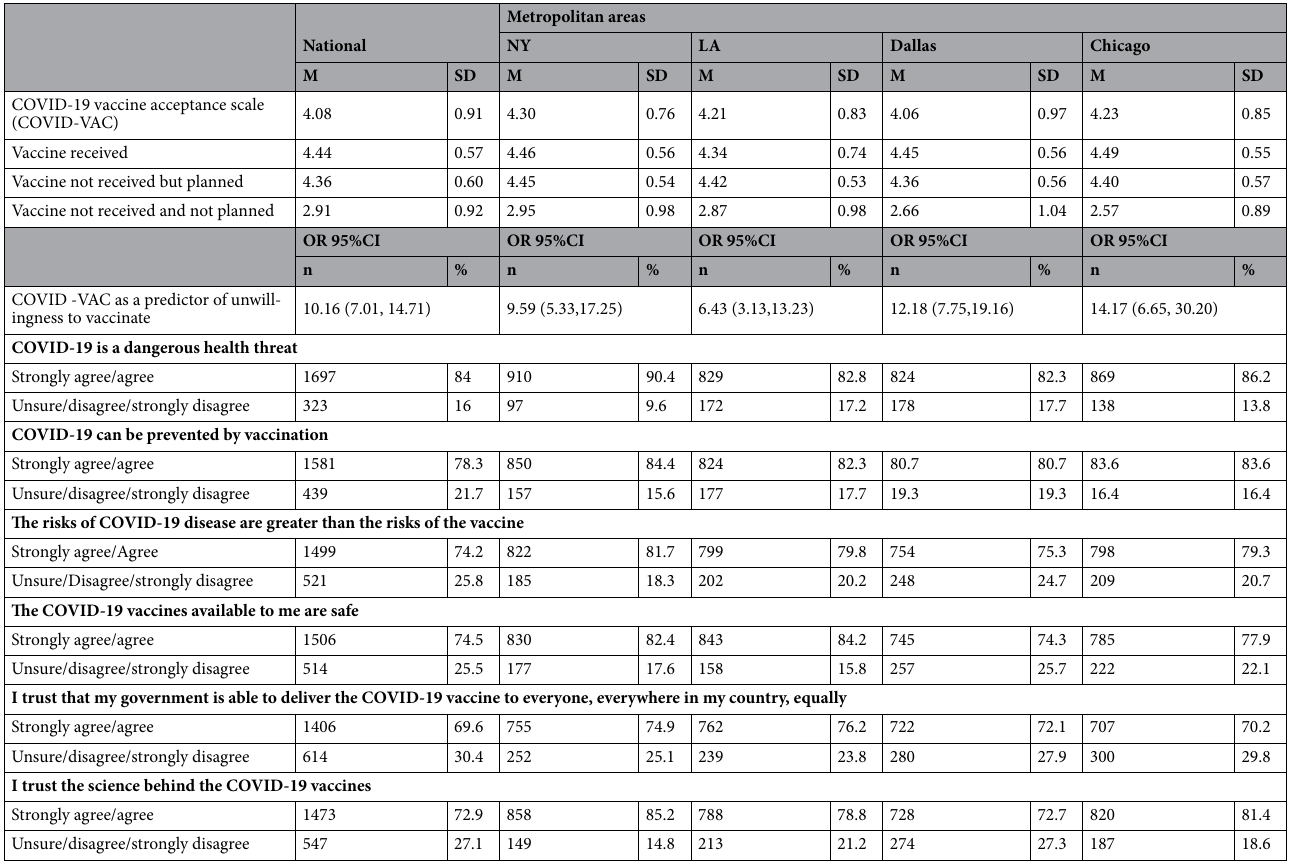
Table 4. COVID-VAC score and score components. % are weighted to the geographic population; COVID -VAC as a predictor of unwillingness to vaccinate was evaluated using weighted logistic regression (outcome = unwillingness to vaccinate). Original response options ranged from strongly agree = 1 to strongly disagree = 5 for the presented item. OR odds ratios, CI confidence